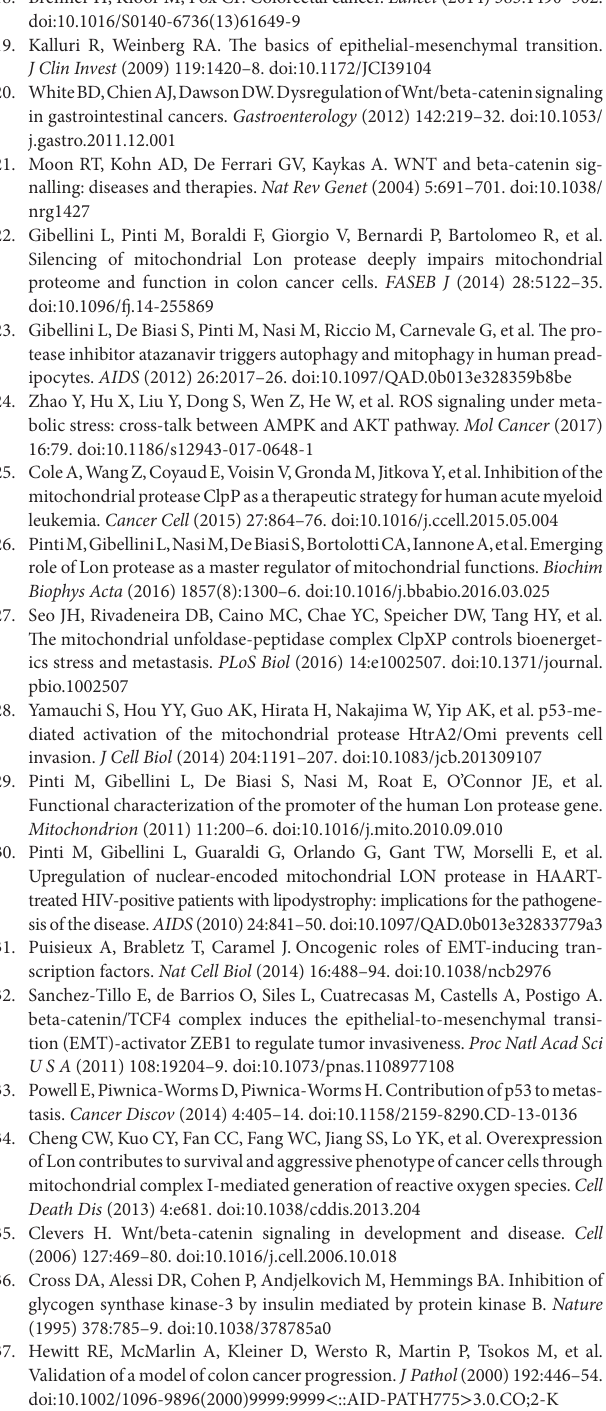
FigUre s2 | LonP1 slightly modulates mitochondrial activity in I407 and RKO colon cancer cells. (a) Representative traces and quantitative analysis of the oxygen consumption rate in indicated cells. Subsequent injections of oligomycin (Oligo), mitochondrial decoupler carbonyl cyanide-4-(trifluoromethoxy) phenylhydrazone (FCCP), complex I inhibitor rotenone (Rot) and complex III inhibitor (AntA) were performed as indicated. (B) Mitochondrial membrane potential quantification as assayed by tetramethyl rodhamine methyl esther